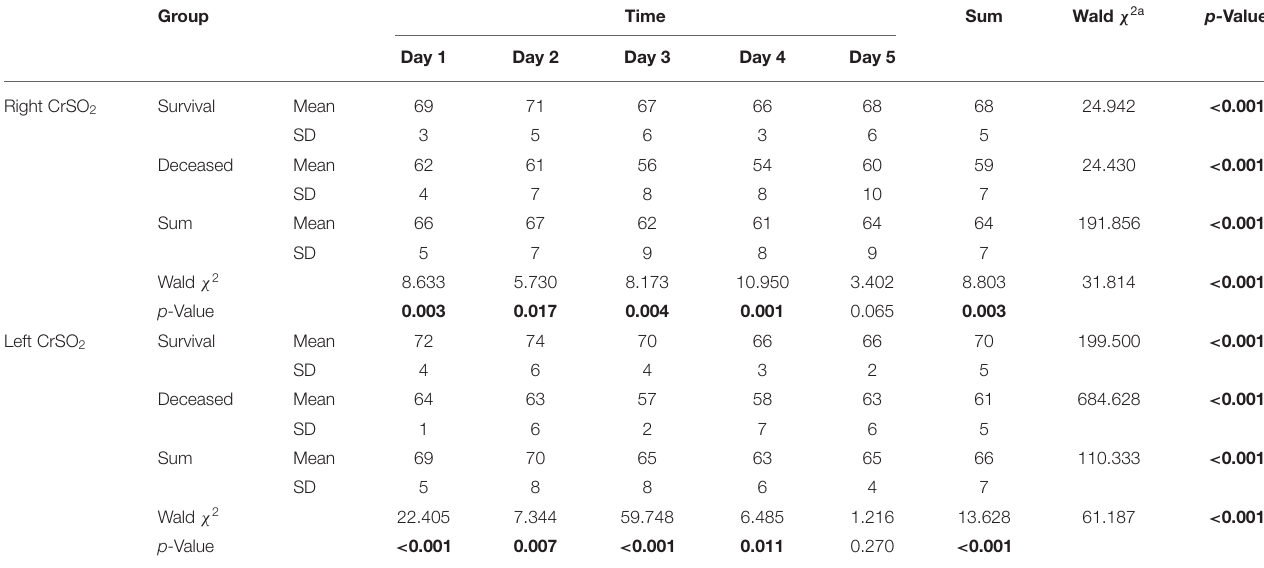
TABLE 2 | CrSO 2 for the first 5 days following ECMO initiation according to PICU mortality. Group Time